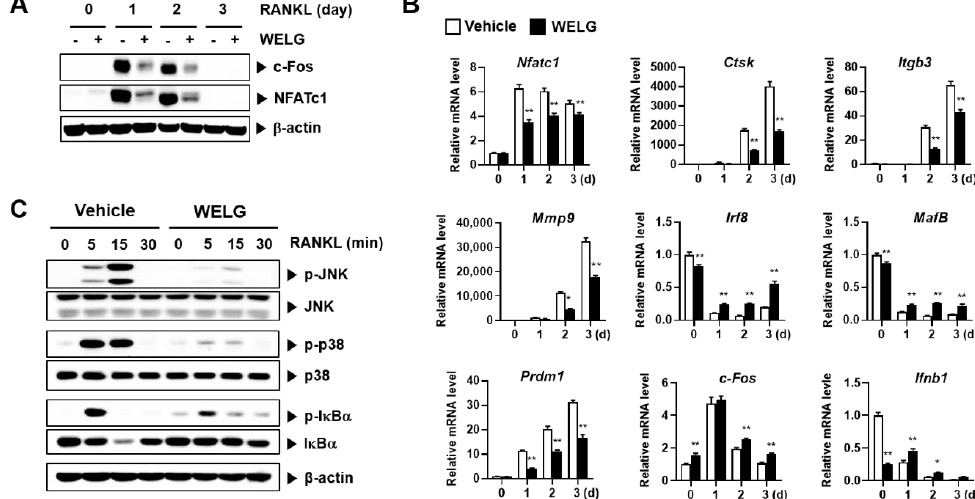
Figure 3. Suppression effect of WELG on RANKL-stimulated signal pathways in osteoclastogenesis. BMMs were activated by RANKL (50 ng/mL) treatment for the indicated days following pretreatment with vehicle or WELG (200 µ g/mL) for 3 h. ( A ) The levels of c-Fos and NFATc1 protein on the indicated days were analyzed by Western blotting. ( B ) The levels of mRNA genes involved in osteoclastogenesis were analyzed by quantitative real-time polymerase chain reaction. * p < 0.05, ** p < 0.01 versus vehicle. ( C ) BMMs were activated by RANKL (50 ng/mL) for the indicated times following pretreatment with vehicle or WELG (200 µ g/mL) for 3 h. The proteins related to RANKL- induced NF- κ B and MAPK signaling pathways were analyzed by Western blotting. All tests were repeated at least three times.